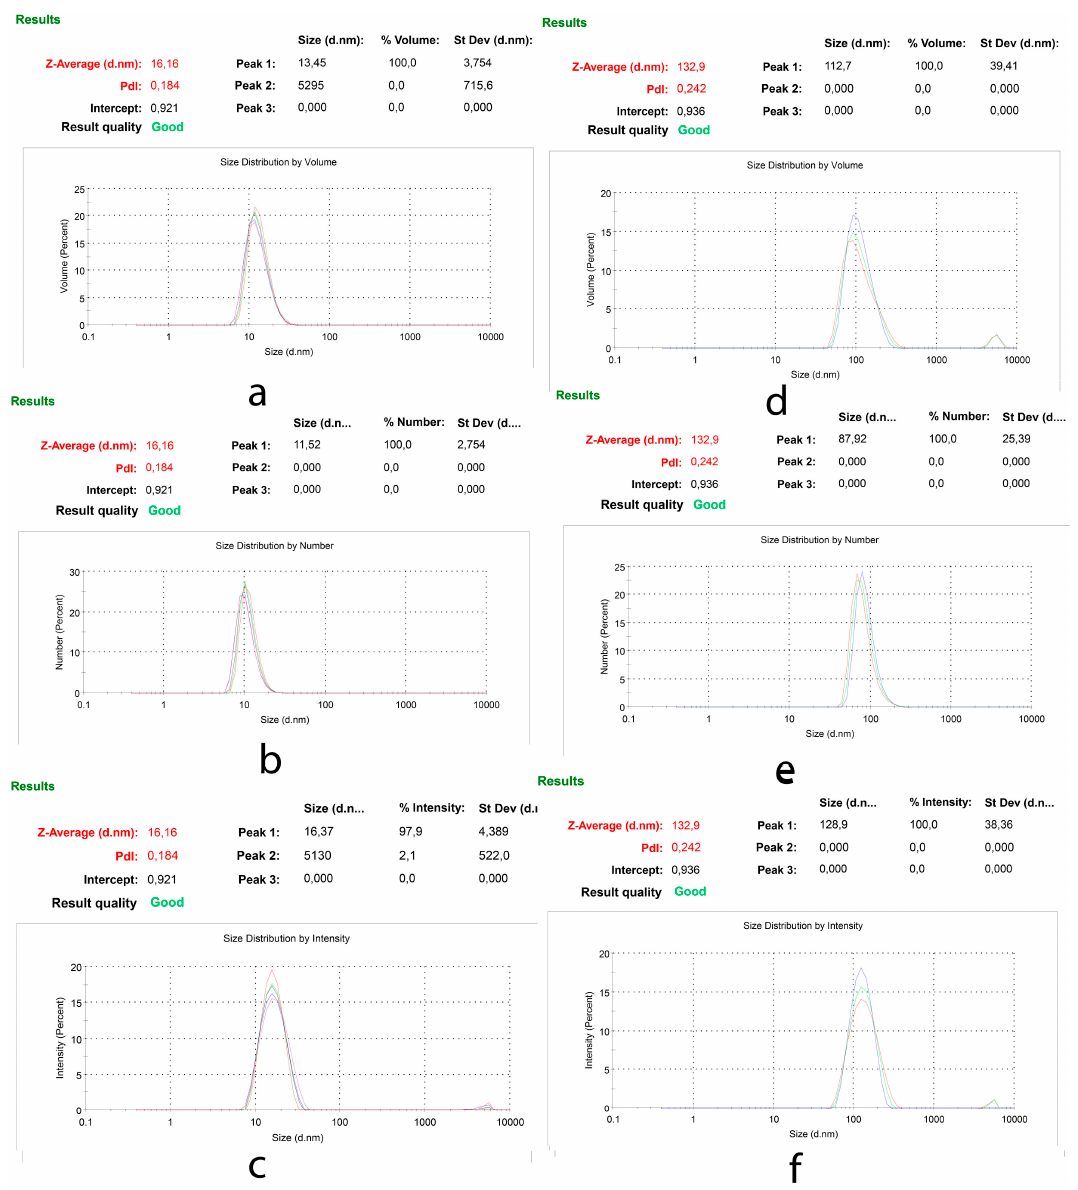
Figure 2. Particle size distribution of SSM and PM; ( a ) % Volume ( b ) % Number ( c ) % Intensity of SSM and ( d ) % Volume ( e ) % Number ( f ) % Intensity of PM.